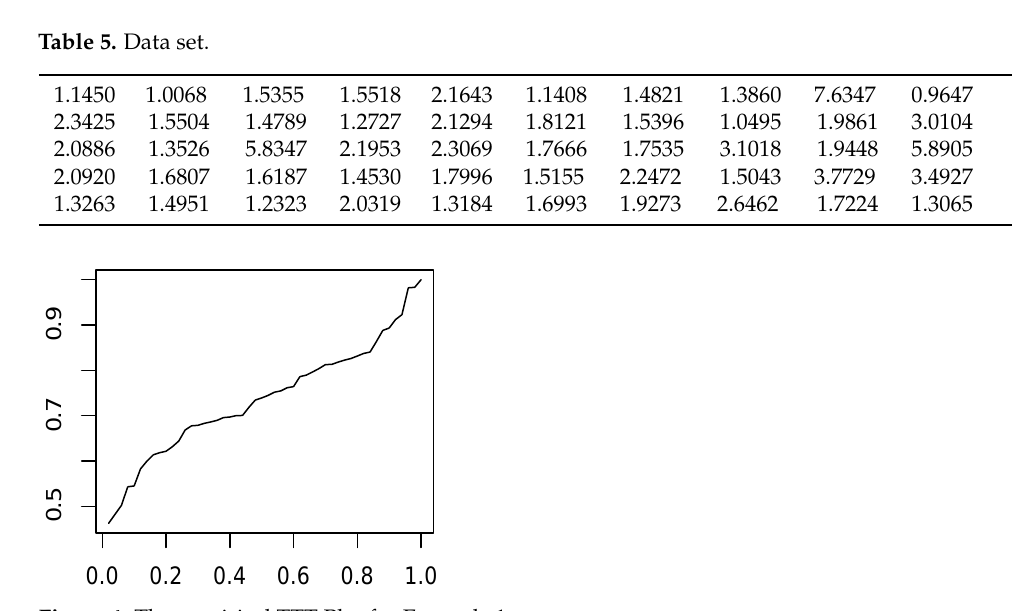
Figure 4. The empirical TTT Plot for Example